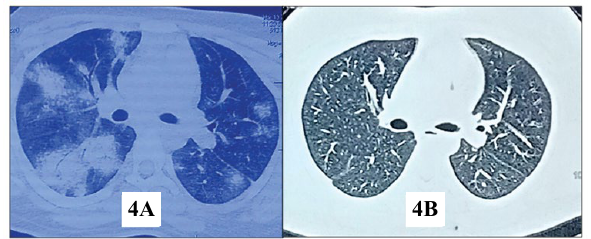
Figure 4: Radiological response to treatment in DAH. HRCT images pre-treatment (4A) and post-treatment (4B) in a patient with Granulomatous Polyangiitis and